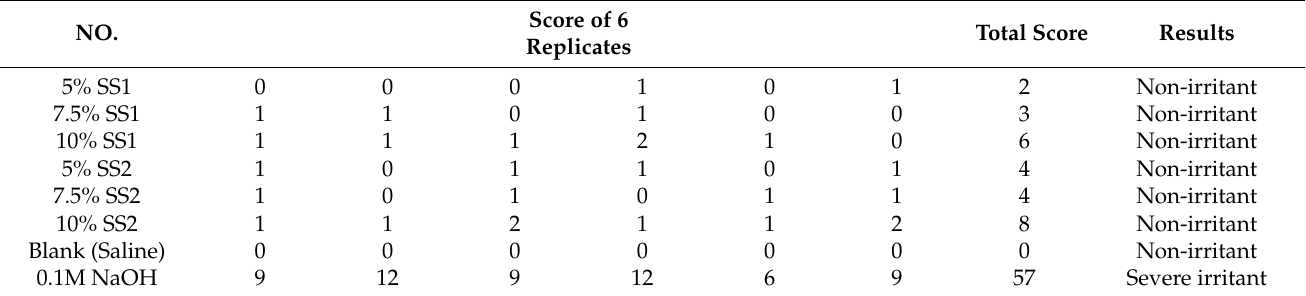
Table 3. End point score of